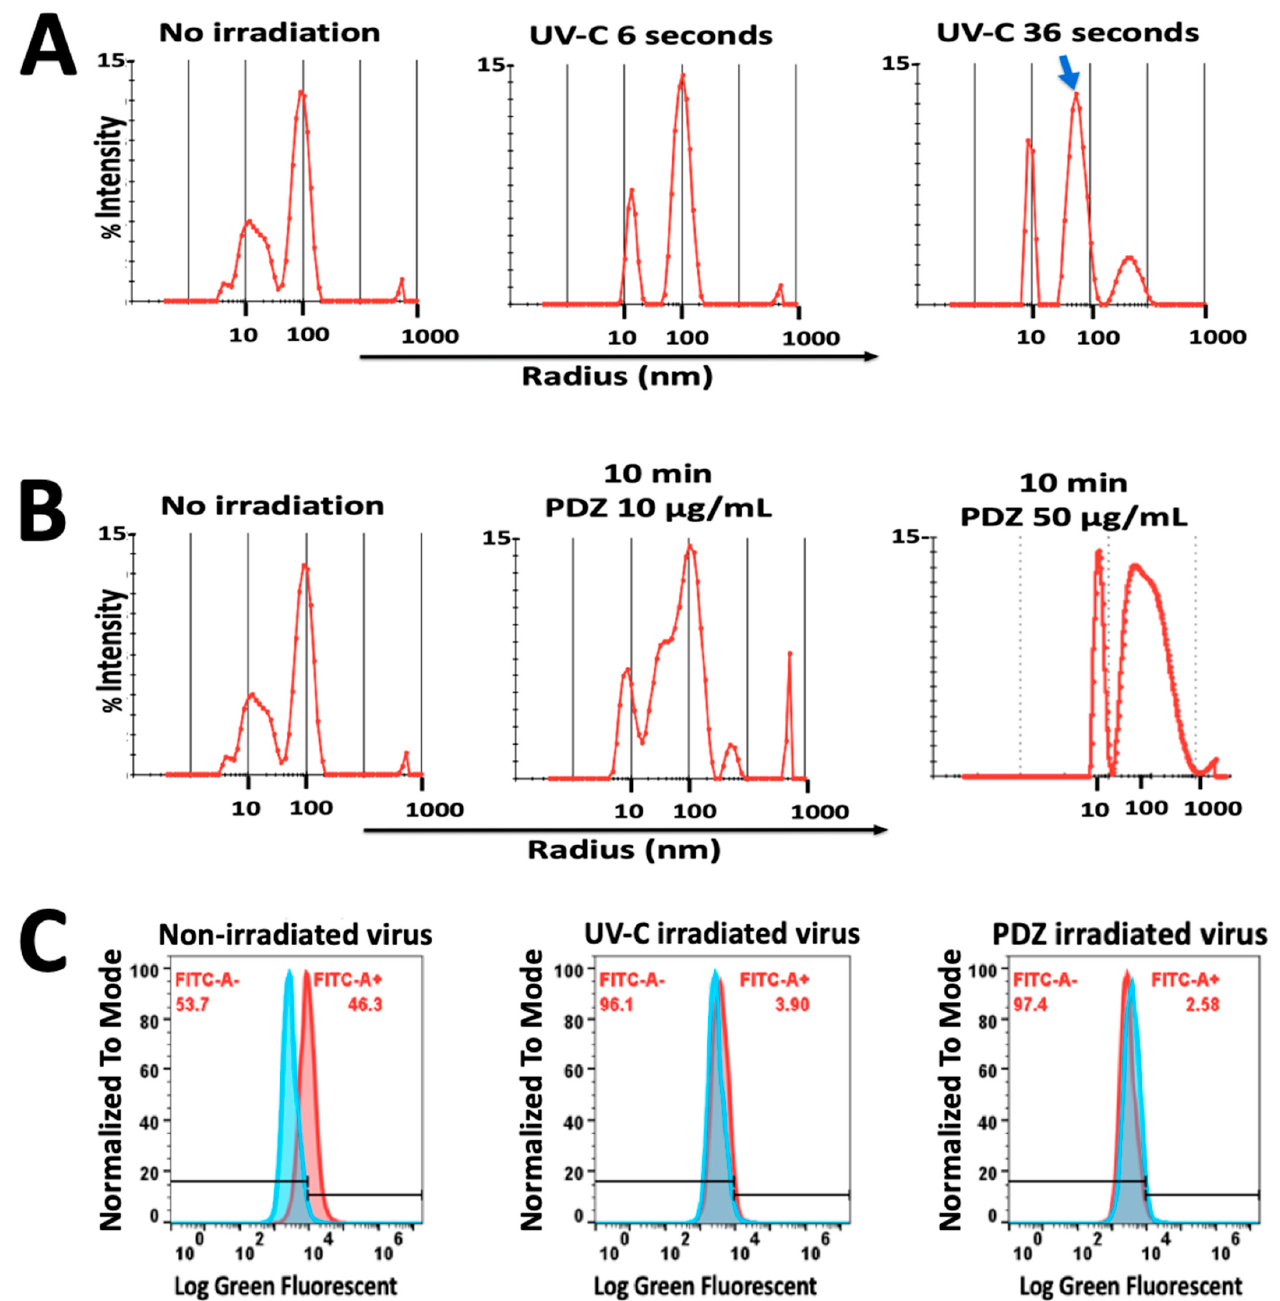
Figure 5. ( A ) Dynamic Light Scattering histograms of hydrodynamic radius (R h ) for pseudovirus showed optimal polydispersity with R h of 100 nm. During 36 s of UV-C irradiation (360 mJ/cm 2 ), a slight decrease in the size of pseudovirus was observed (Blue arrow) with no significant aggregation; ( B ) PDZ-based PDI significantly affected the size and polydispersity of the virus, resulting in major aggregated particles in a higher concentration of PDZ (50 μ g/mL); ( C ) Flow cytometric diagram on the left demonstrated the percentage of pseudovirus-infected cells expressing ZsGreen Fluorescent protein. The middle and right diagrams represent the cells infected by UV irradiated-virus and PDZ-based PDI virus, which do not express ZsGreen protein. FITC rate indicates the green fluorescent emission from ZsGreen. Data are ± means S.E.M. ( n = 2).